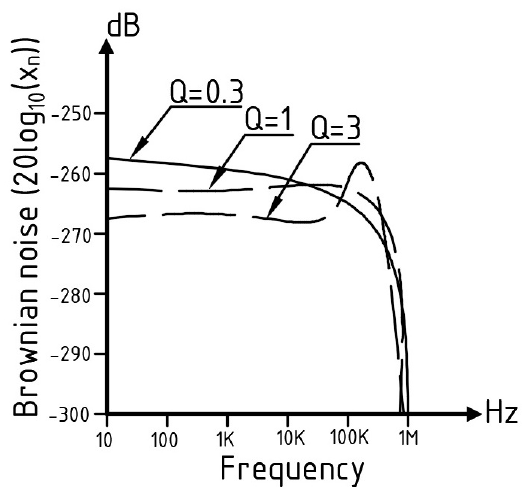
Figure 11. Calculated Brownian noise component of a MEMS element. Adapted from